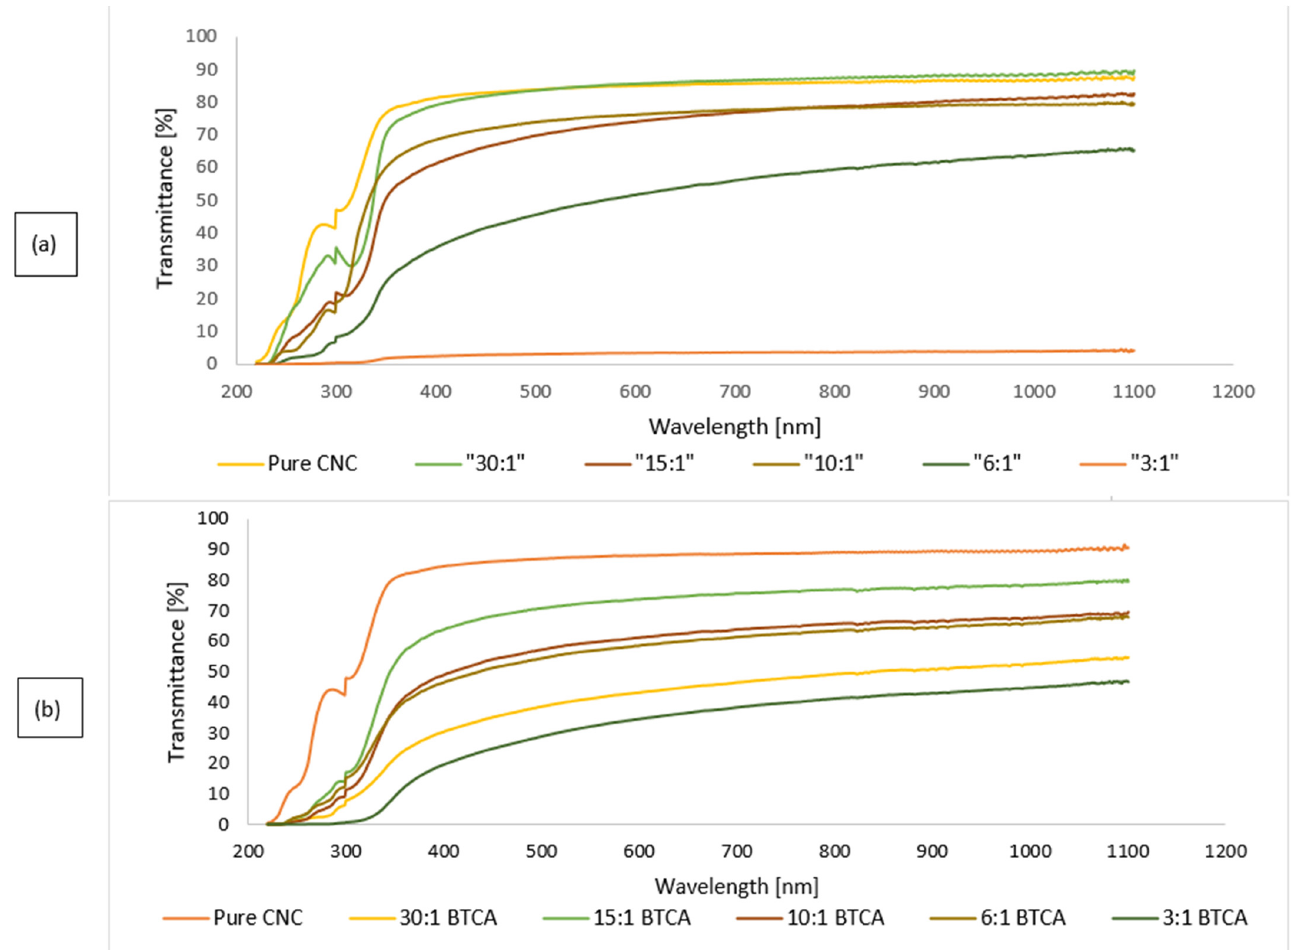
Figure 3. Transparency of CNC, crosslinked CNC films, and nanocomposite CNC/CZ films with different CZ contents. ( a ) Non crosslinked films, ( b ) crosslinked films.